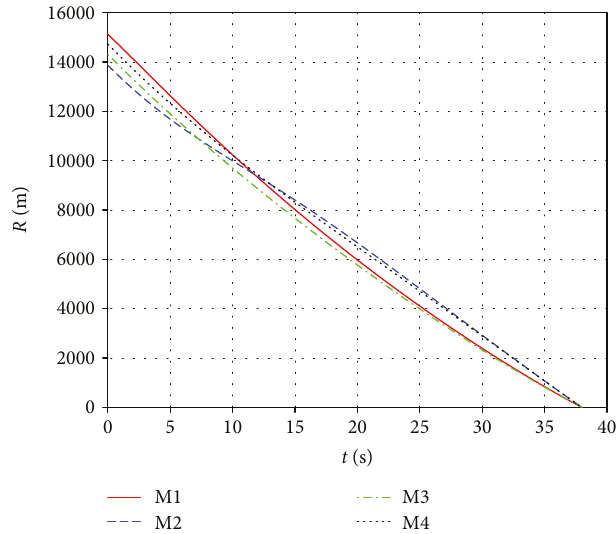
Figure 12: Relative distances between missiles and the target with impact time and angle